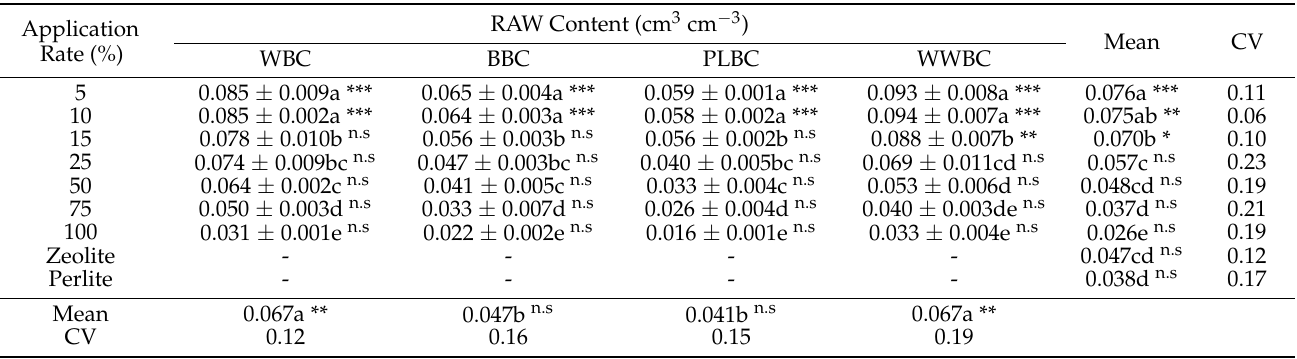
Table 2. ANOVA for the readily available water (RAW) of sandy soil amended with biochar from woodchip (WCB), bagasse (BBC), poultry litter (PLBC) and waterweed (WWBC) at different applica- tion rates compared with zeolite and perlite. RAW Content (cm 3 cm − 3 )